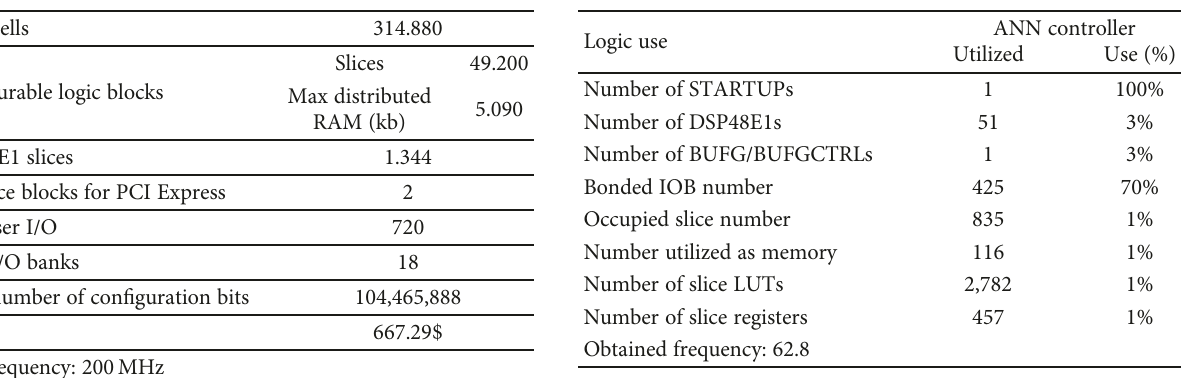
Table 9: Summary of device